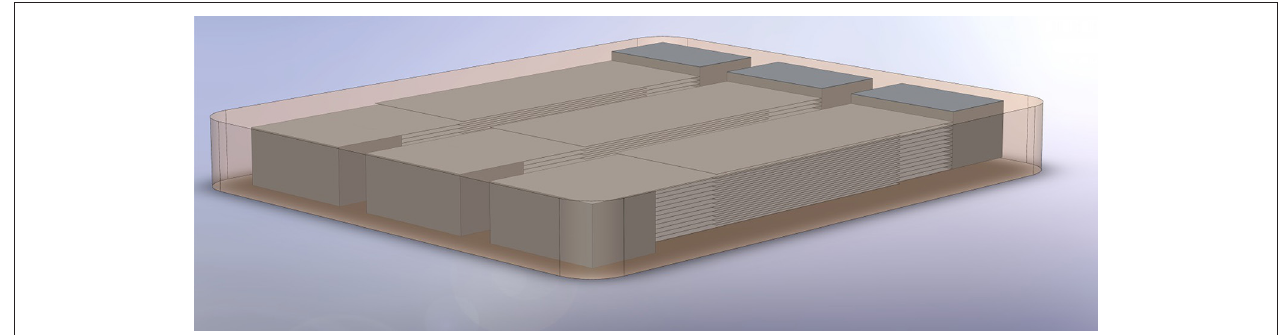
FIGURE 3 | Design of the second prototype: a glass-ceramic material with three integrated silver capacitors. The glass-ceramic is shown semi-transparent in the graphic to reveal the inner silver structure. The structure consists of a total of 35 ceramic layers of about 100 µ m and 26 integrated conductive silver layers for